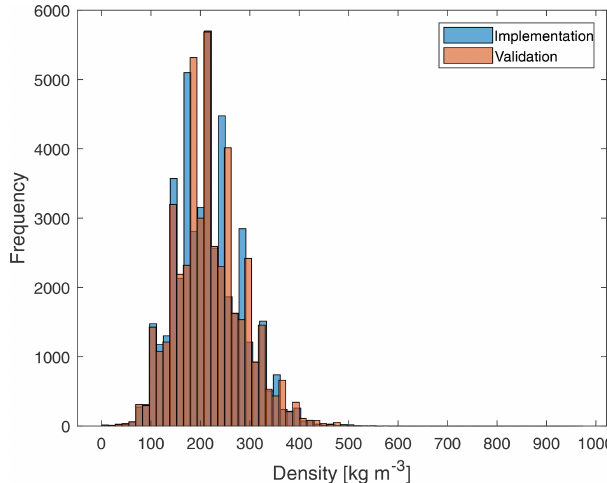
Figure 2. Histogram of the implementation and validation densities for Eurasia for 2000–2009.